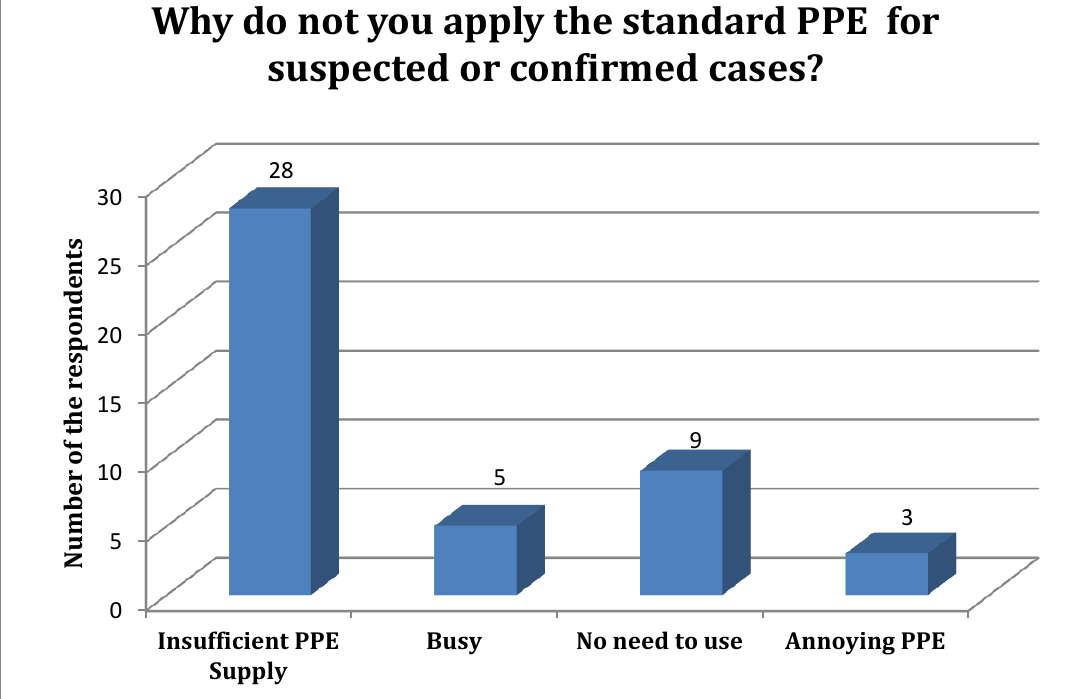
Figure 1. Bar chart showing the factors for not applying the standard